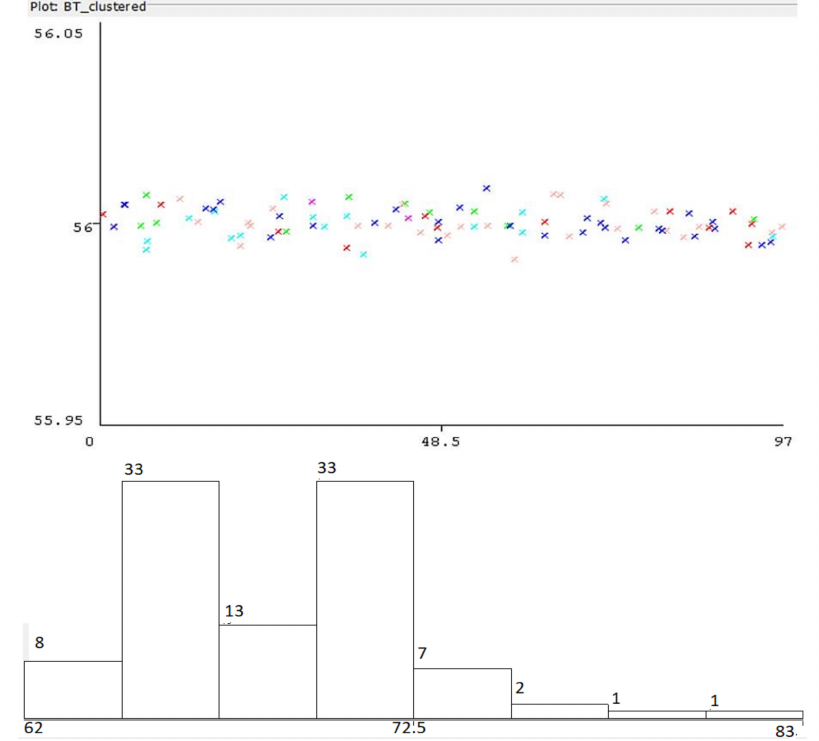
Figure 25. Dispersion of received signal strength recorded values during the test with BT source, LoS condition, 2 m from transmitter (horizontal axis—level [dBm], vertical axis: number of receptions). Colors in the above figure show belonging to time clusters when values were recorded.